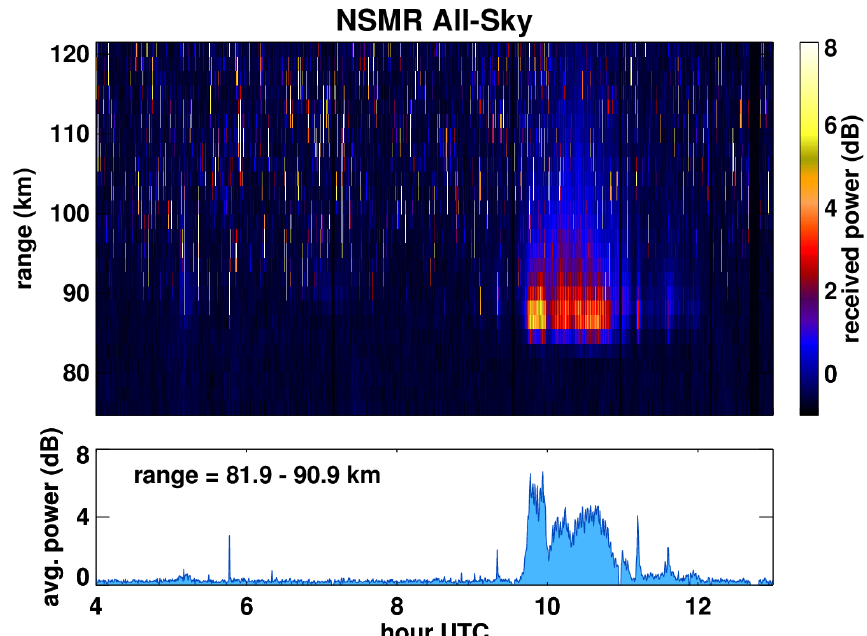
Figure 2. NSMR all-sky received power (incoherently averaged across all five antennas) for 19 July 2020: 30s averages in 1.8km range bins. Plot intensity has been capped at 8dB to enhance the visibility of weak features. The bright vertical segments above 85km are meteor echoes.